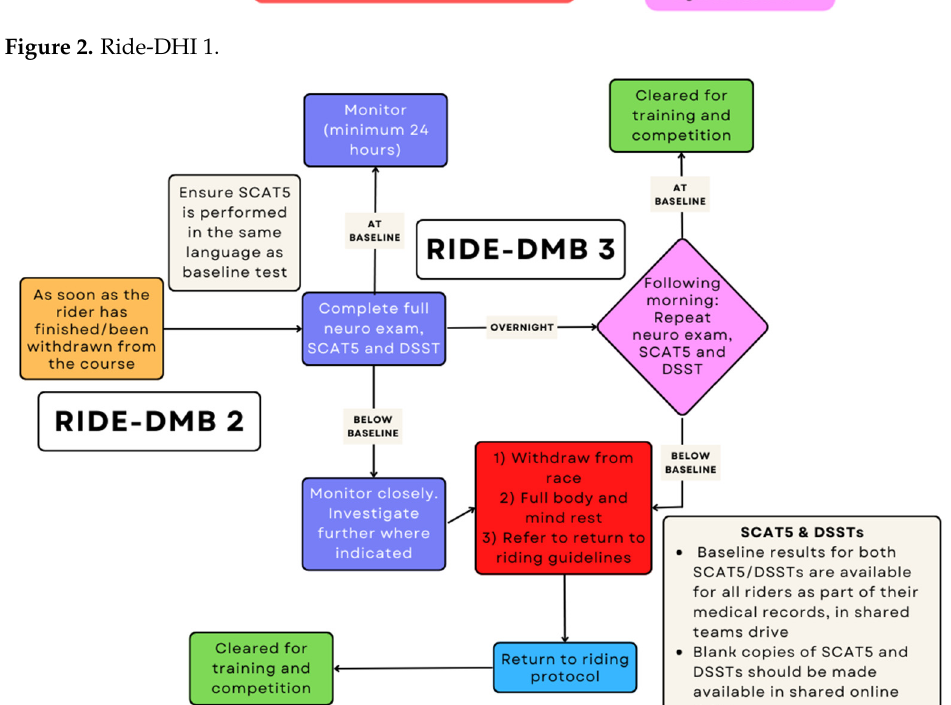
Figure 3. RIDE-DMB 2 and